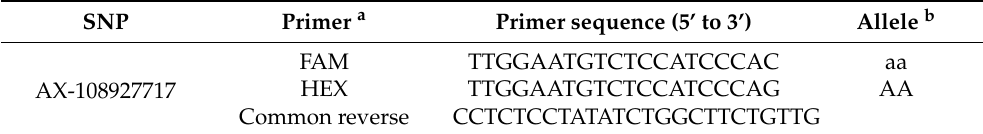
Table 4. The primers of the kompetitive allele-specific marker for alleles of Qslu.sicau-2B-2 that were used in this study.